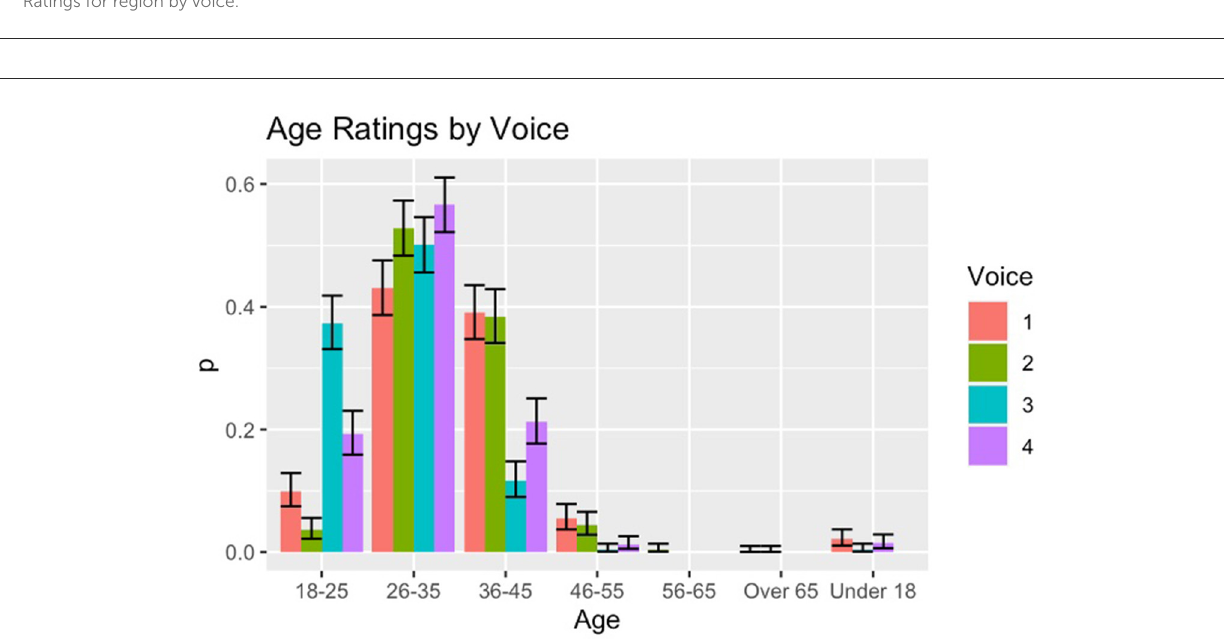
FIGURE2 Ratings for age by voice.